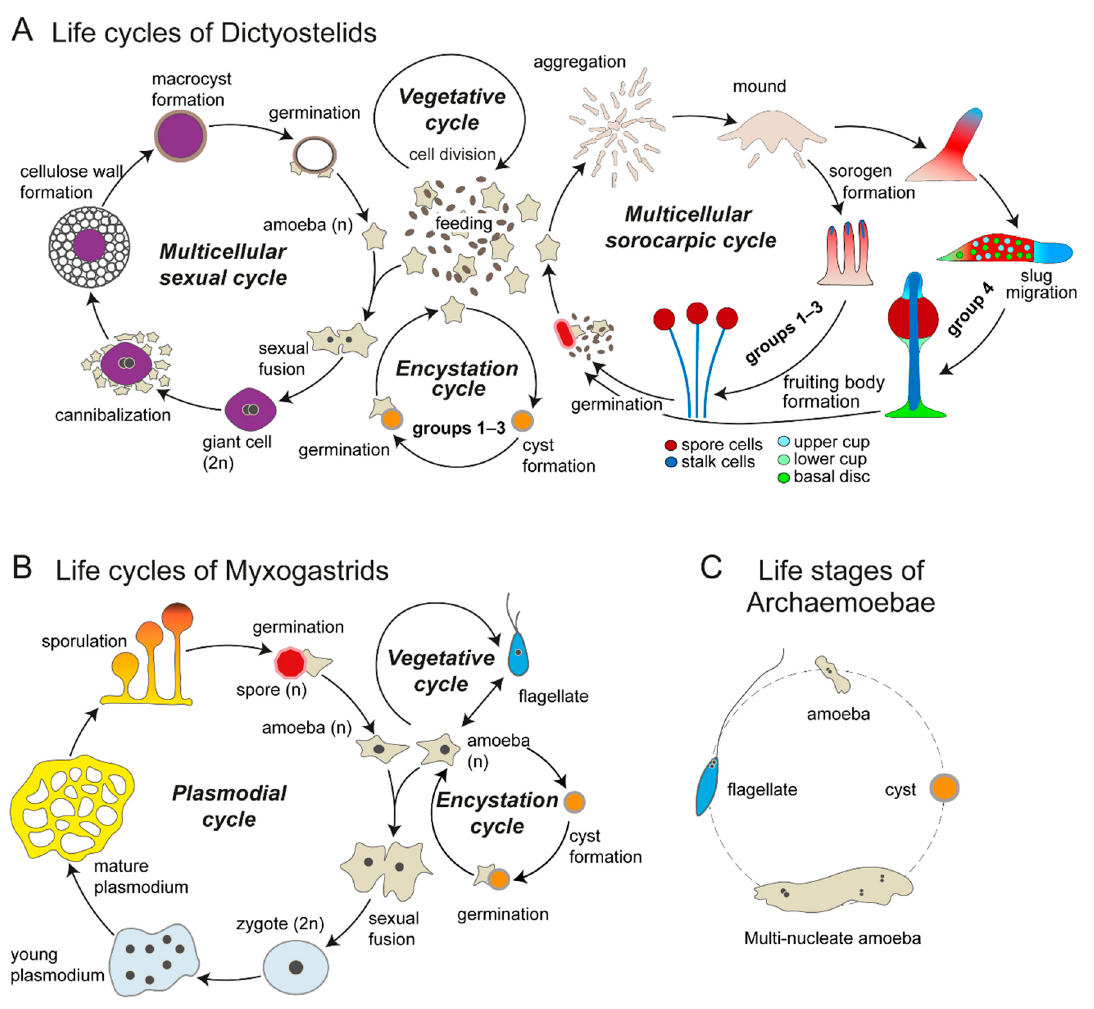
Figure 1. Life cycles of Amoebozoan groups related to the Dictyostelids. ( A ). The Dictyostelids show four different cycles, the unicellular vegetative and encystation cycles and the multicellular sexual and sorocarpic cycles. The depiction of the sorocarpic multicellular cycle shows generalised differences between Dictyostelids in Groups 1–3 and those in Group 4. Different cell types in the fruiting body are shown in different colours. Cup cells and basal disc cells are found only in Group 4, while encystation is lost in this group. ( B ). The Myxogastrids show three major life cycles, vegetative, plasmodial (or sexual), and encystation, as depicted here. In addition, not shown here, the plasmodium can turn into a dormant dehydrated structure, called sclerotium, in harsh environmental conditions, and can also be produced with haploid cells (apogametic cycle). Redrawn after Figure 5 in [35]. ( C ). In many species of Archaemoeba, multiple cellular phenotypes, such as amoeba, multinucleate amoeba, cyst, and flagellate are known to exist, but there is not much information about how they transition from one to another. Redrawn after Figure 1 in [36].